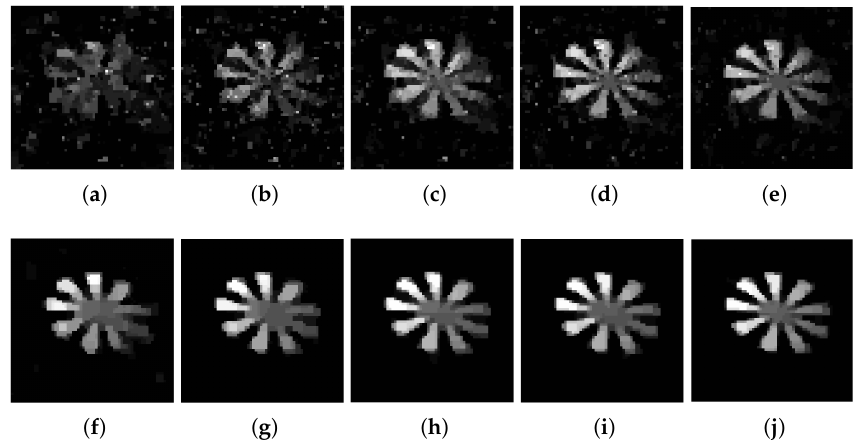
Figure 3. Reconstitution of images measured with the Gaussian random matrix under compression ratio at ( a ) 0.1, ( b ) 0.2, ( c ) 0.3, ( d ) 0.4, ( e ) 0.5, and reconstitution of images measured with adaptive measurement matrix under compression ratio at ( f ) 0.1, ( g ) 0.2, ( h ) 0.3, ( i ) 0.4, ( j ) 0.5, the reconstruction algorithm is TVAL3 and the resolution of the image is 64 × 64 for